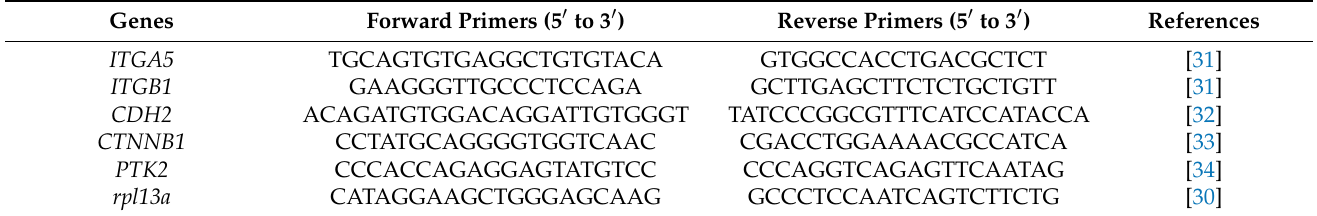
Table 1. Primers used to assess the expression of genes involved in cell adhesion and migration. Genes Forward Primers (5 (cid:48) to 3 (cid:48) ) Reverse Primers (5 (cid:48) to 3 (cid:48)